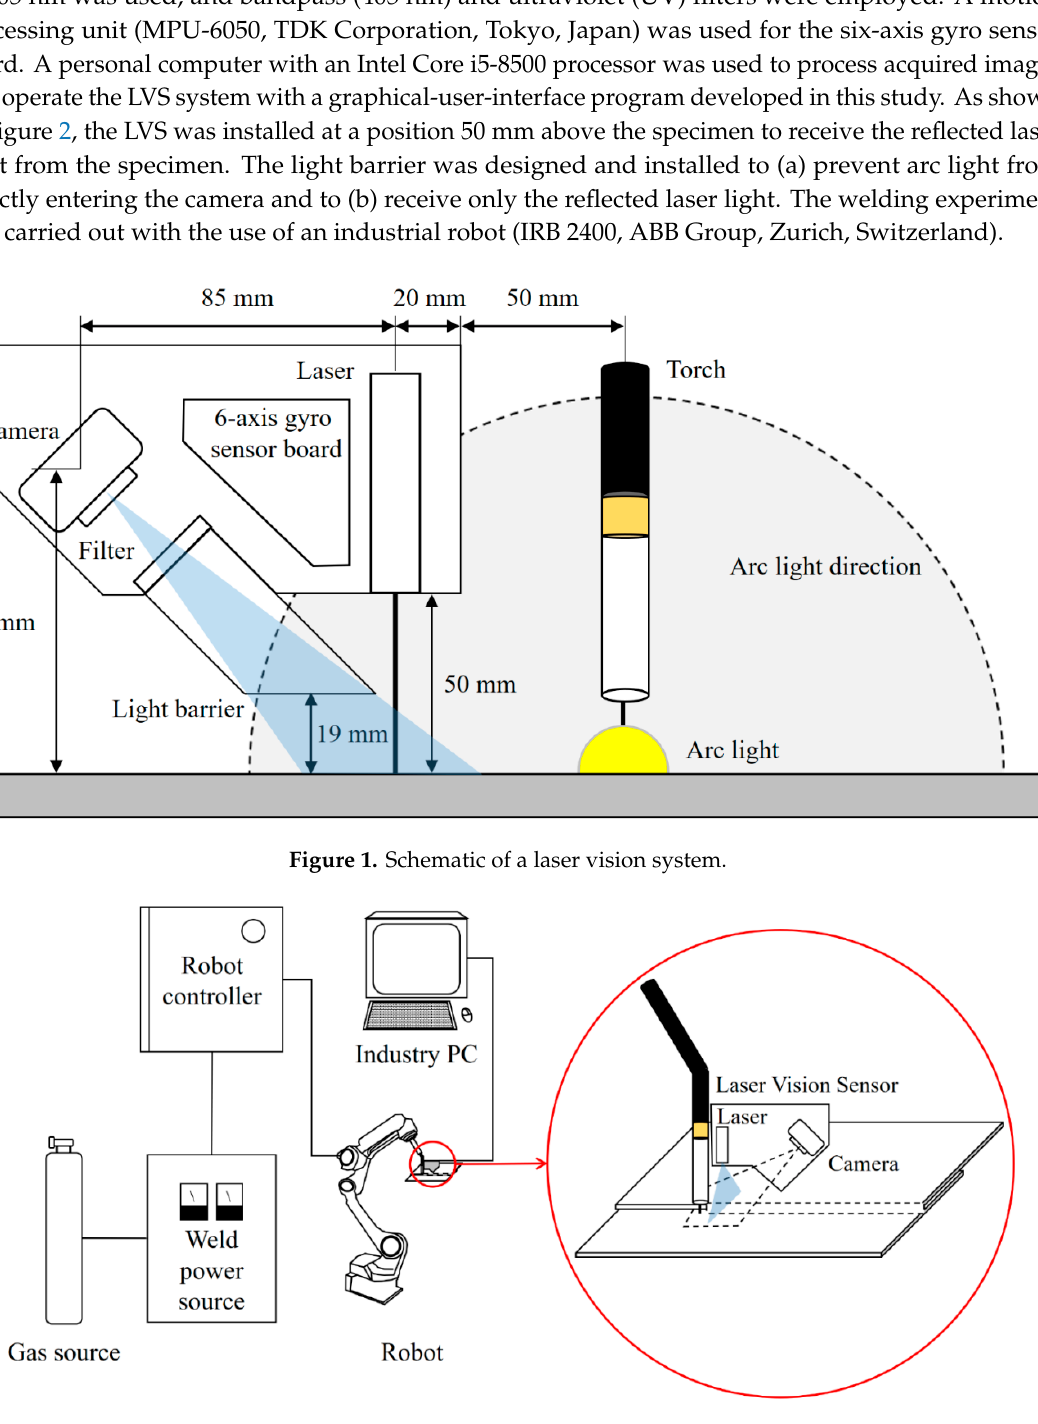
Figure 2. Experimental setup of a welding system with an LVS.